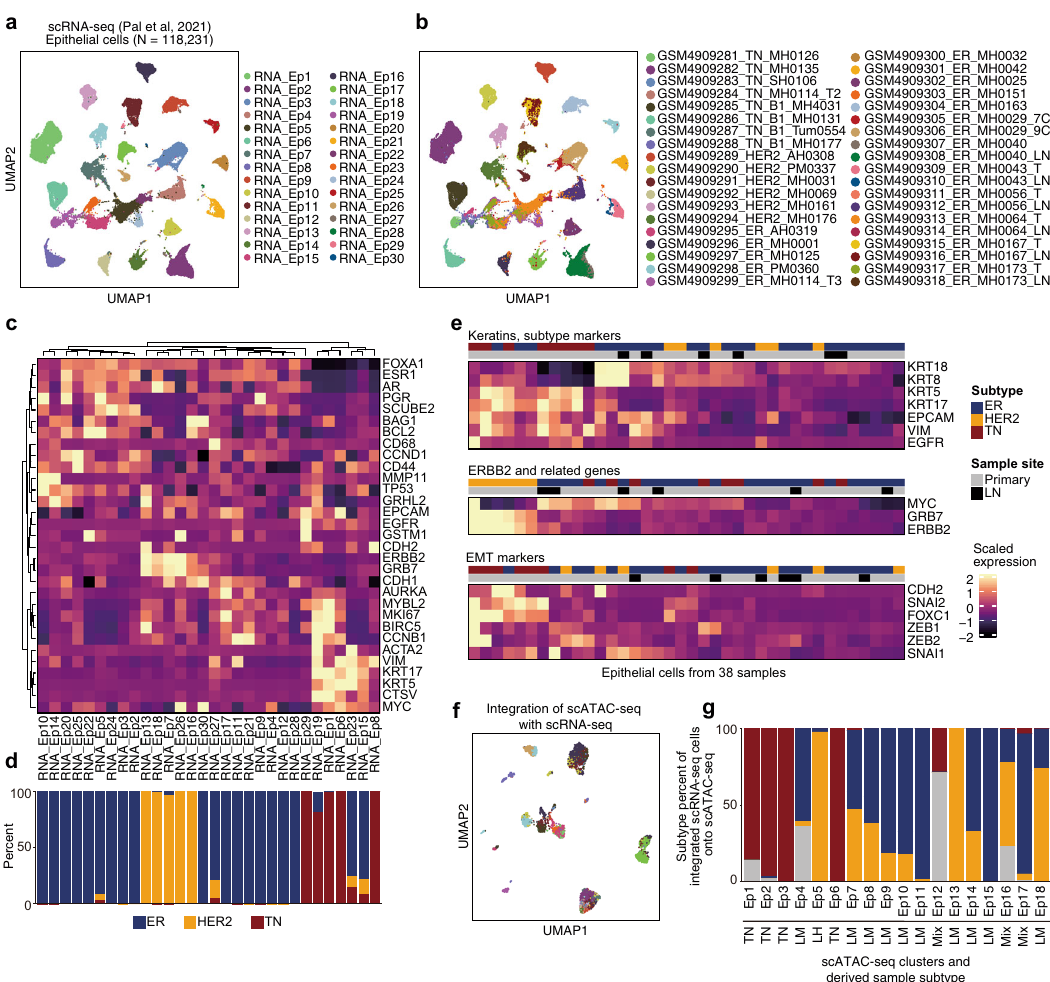
Fig. 3 Integrative analysis of previously reported scRNA-seq results and our scATAC-seq data. a , b UMAP of subclustering of the epithelial cell transcriptome reported in a previous scRNA-seq study (Pal et al., 2021), colored according to the corresponding epithelial clusters in a and corresponding samples in b . c Heatmap of scaled expression of marker genes. d Breast cancer subtype composition of each epithelial cluster, according to the scRNA-seq. e Heatmap of scaled expression of genes corresponding to the results in Fig. 2e – g. Unlike panel in c , the cells are grouped by sample and average scaled expression is presented. f UMAP visualization of 4,141 epithelial chromatin pro fi les, colored according to the linked scRNA-seq clusters presented in panel a . Based on gene activity scores, scATAC-seq cells were linked to scRNA-seq exhibiting a similar expression pattern. g Subtype composition of scRNA-seq cells associated with each scATAC-seq gene score) was consistent with actual gene expression levels scale scRNA-seq data 26 . Of the 184,116 transcriptome pro fi les when determining TME properties. obtained from 38 primary breast or metastatic lymph node samples of 32 patients, we identi fi ed 32 clusters using Seurat 27 , which enabled clear classi fi cation of breast cancer and TME cells (Supplementary Fig. 3a – b). By subclustering TME cells, we (Fig. 3b and Supplementary Table 7); expression of basal cell markers ( VIM , EGFR , and KRT5/17 ) was high in TNBC-derived clusters, whereas luminal cell markers ( KRT8/18 and FOXA1 ) were highly expressed in luminal-derived clusters (Fig. 3c, d). We also examined the gene expression levels of keratins, ERBB2-related genes, and EMT markers in the epithelial cells of each sample. We found that basal keratins ( KRT5/17 ), EGFR , and VIM were highly Fig. 1c – e and Supplementary Table 6). Based on the observations expressed in TNBC samples, whereas ERBB2 and GRB7 expression from a shared expression program for TMEs among patients (Fig. were commonly high in HER2 + and some luminal tumor samples; 1c and Supplementary Fig. 3d; refs. 17 – 20 ), we integrated the MYC was coupregulated in some tumors, and EMT markers were chromatin pro fi ling with the transcriptome in TME cells by relatively highly expressed in TNBC samples compared with their comparing the gene score matrix from our scATAC-seq with the expression in other subtypes (Fig. 3e). In addition to TME cell gene expression matrix from the scRNA-seq; accordingly, we analysis, we performed cross-platform integration between identi fi ed a similar same cell type annotation (Supplementary Fig. scATAC-seq and scRNA-seq for epithelial cells (Fig. 3f). Although the linkage between cells partially re fl ected breast cancer 3f). Thus, scATAC-seq-based estimation for gene expression (i.e.,